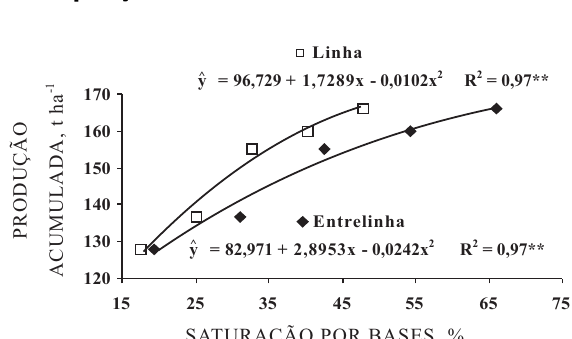
figura 5b. Observa-se o bom ajuste dos dados de produção acumulada ao modelo quadrático, em função das doses de corretivo.